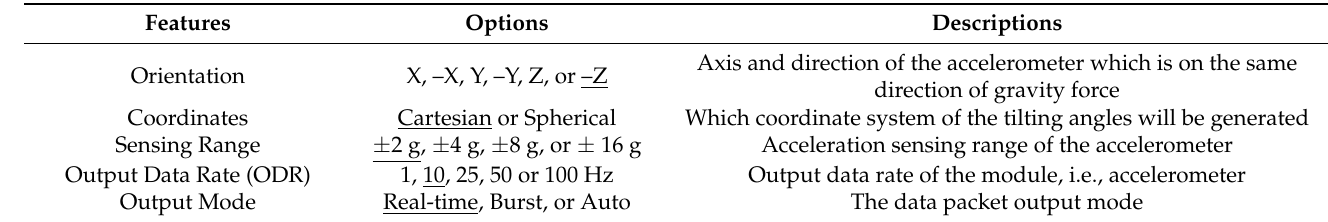
Table 1. Configurable features of the BASIC module.